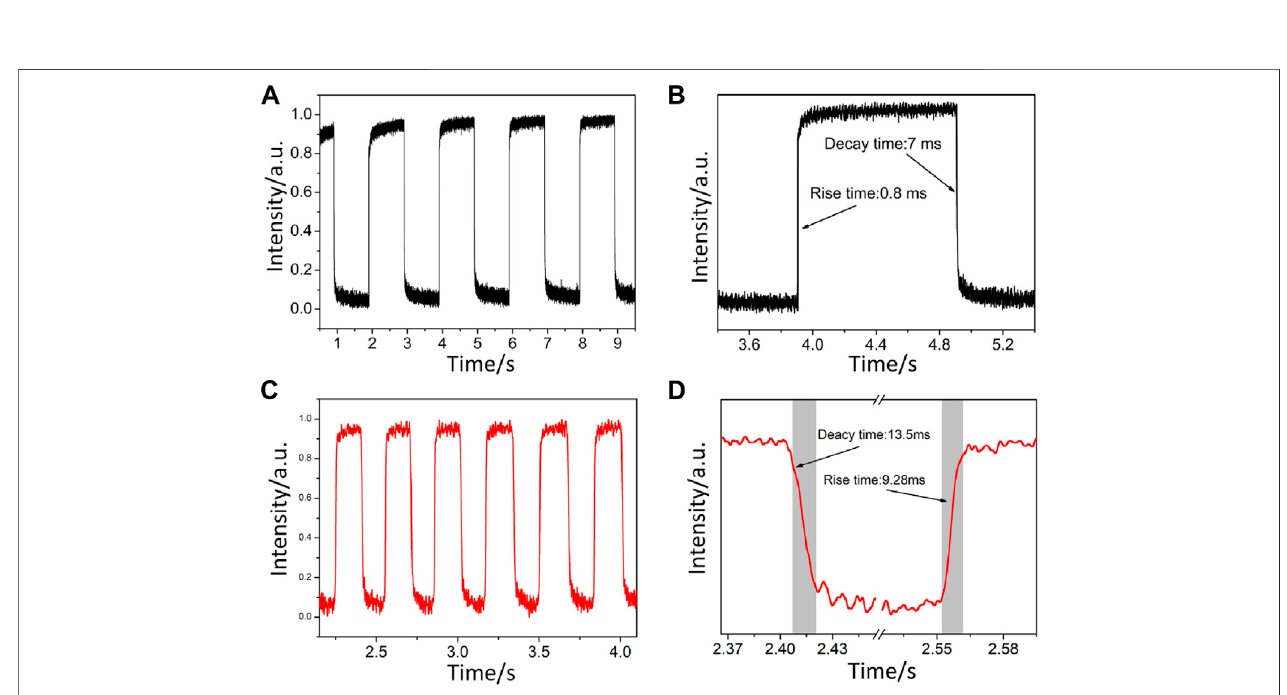
FIGURE 3 | Photo-response speed of the fl exible device. (A) Multi-cycle for SIPF, (B) Single cycle for SIPF, (C) Multi-cycle for SOPF, (D) Single cycle for SOPF.